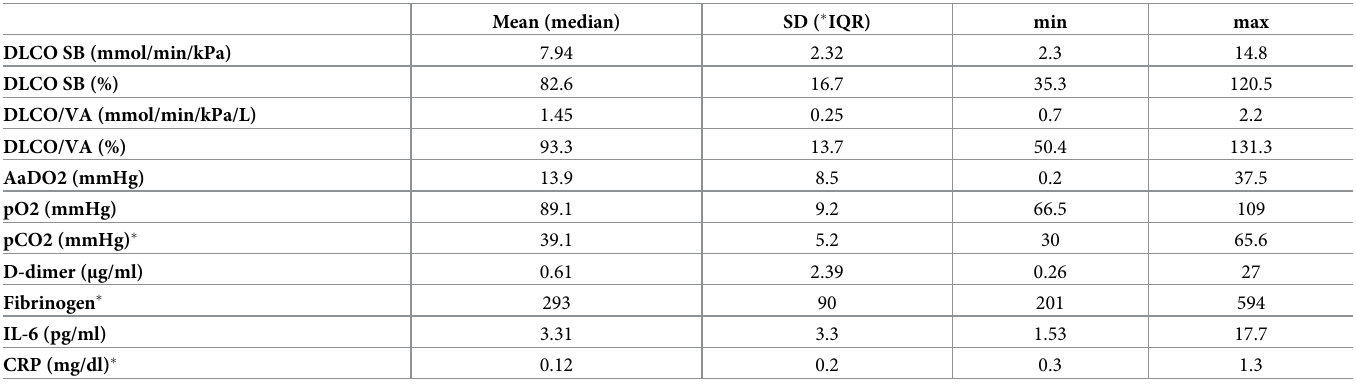
Table 1. Subject characteristics at study